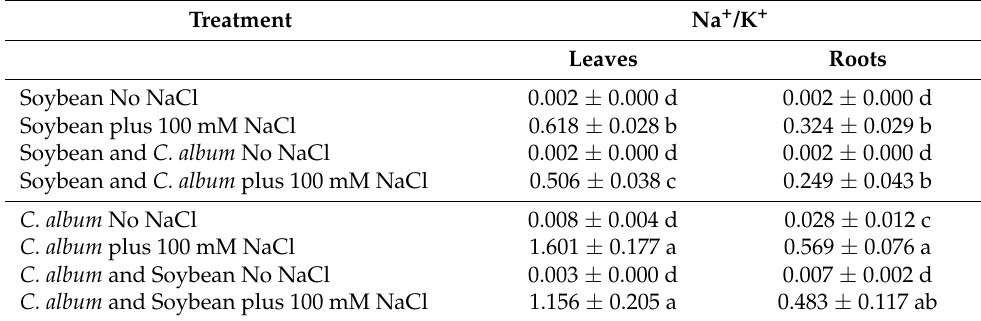
Table 3. Na + /K + ratios in leaves and root of soybean and C. album, treated and nontreated with NaCl. Letters along columns indicate significant differences within both species groups at p < 0.05, n = 3 (+SE). The experiment was replicated twice, and only data from one representative experiment are